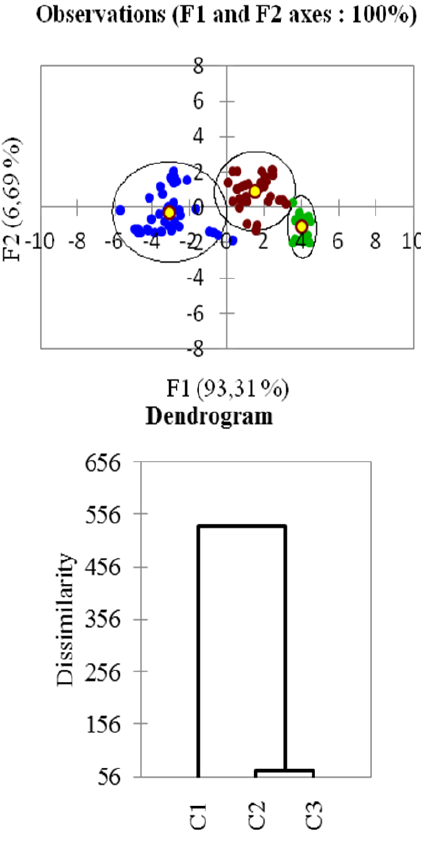
Fig. 11. Virtual representation of the observations on discriminated axis showing the different classes and performed from the discrim- inant factor analysis (on the top panel). Circles represent different identified classes with a confidence interval of 95%. Blue dots rep- resent the first class (midtroposphere thin cirrus), red dots represent the second one (thick upper troposphere cirrus) and the green dots represent the third class (upper troposphere thin cirrus). Dendogram derived from the hierarchical ascendant classification is shown on the bottom